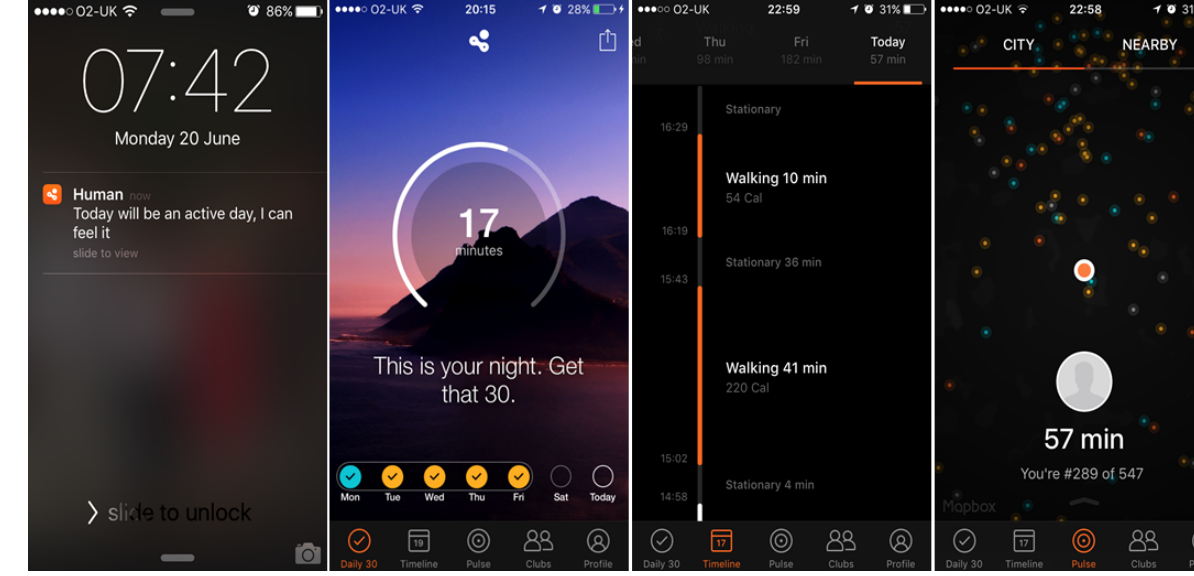
Figure 1. Screenshots of Human.